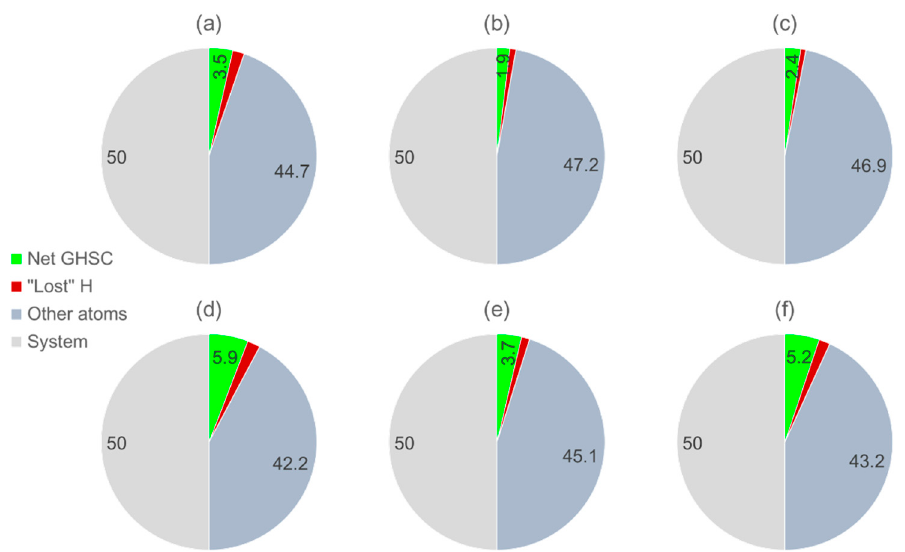
Figure 23. Net (i.e., useable) gravimetric hydrogen storage capacity (GHSC, in wt% H 2 ) for a storage system taken as a whole, in the case of ( a ) ammonia borane as liquid-state hydrogen carrier in water (in stoichiometric conditions such as in Equation (6)), ( b ) ammonia borane as liquid-state hydrogen carrier in methanol (in stoichiometric conditions such as in Equation (17)), ( c ) ammonia borane in saturation in the BmimCl ionic liquid (assuming the release of 75% of the borane’s hydrogen), ( d ) 80 wt% of ammonia borane doped with 20 wt% of a chemical additive (assuming the release of 75% of ammonia borane’s hydrogen), ( e ) ammonia borane confined into a scaffold (50–50 wt%; assuming the release of 75% of the ammonia borane’s hydrogen) and ( f ) lithium amidoborane as derivative of ammonia borane (assuming the release of 75% of the amidoborane’s hydrogen). The weight percentages of the lost hydrogen atoms, of the other atoms (e.g., B, N, C and O) and of the storage system (set at 50 wt% of the total weight) are shown.